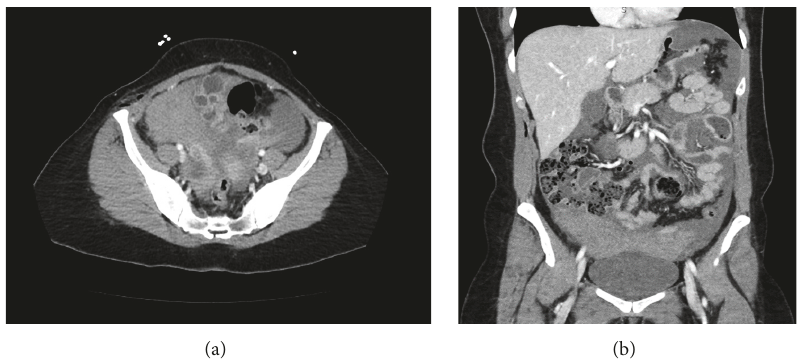
Figure 1: Axial (a) and coronal (b) abdominal CT scan showing